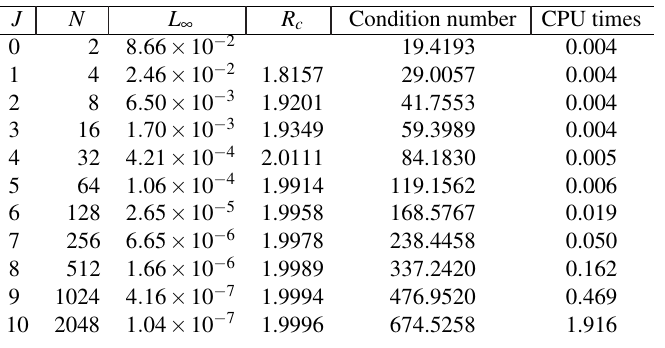
Table 1. L ∞ of Test Problem 1 at different numbers of collocation points